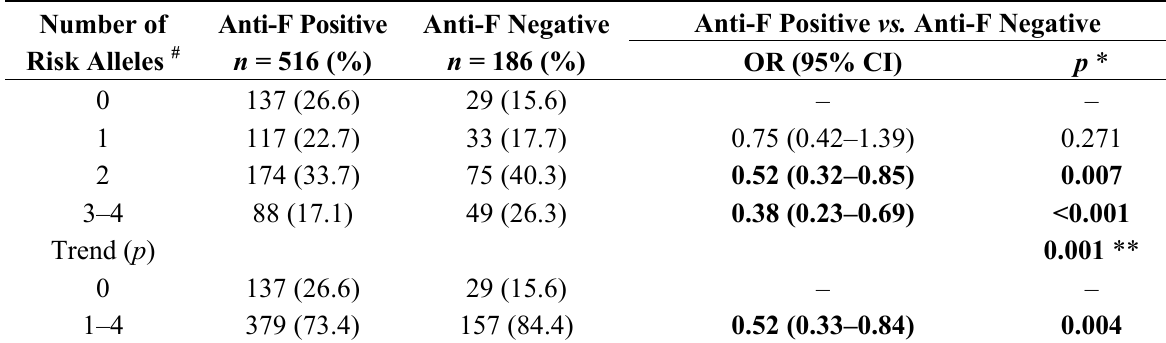
Table 3. Cumulative effects on combined variant alleles (rs3077-T and rs9277534-G) with risk of anti-F antibody